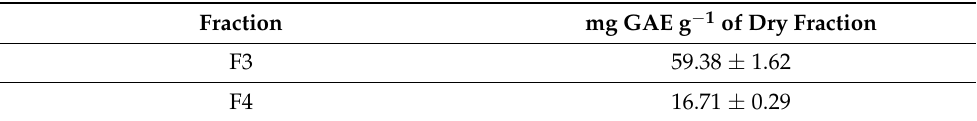
Table 5. Total phenolic content of red algae A. rigida crude fractions (Av ± SD; n = 3) expressed in mg GAE per g of dry